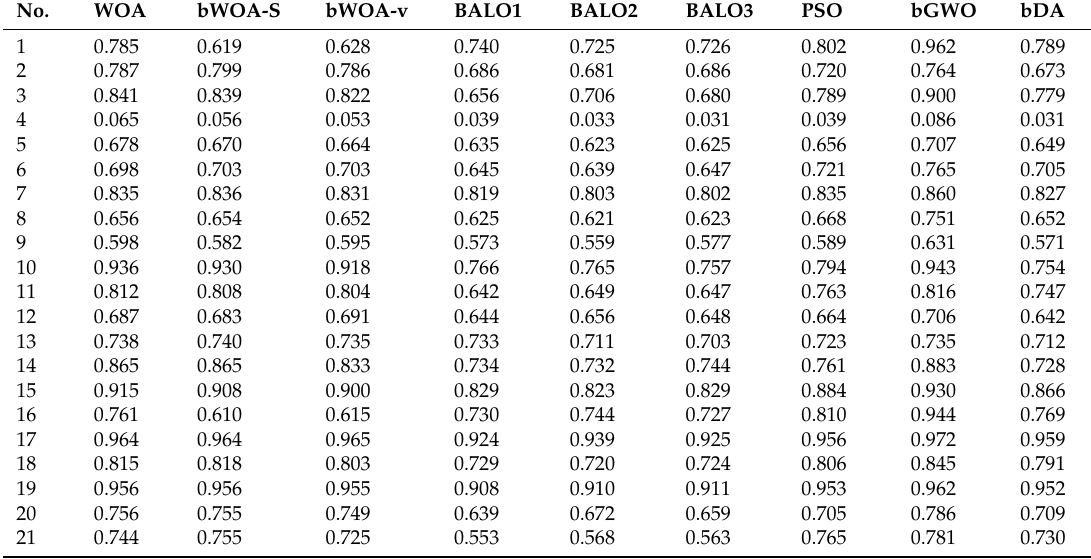
Table 8. Average classification accuracy on the different datasets for the compared algorithms using mixed